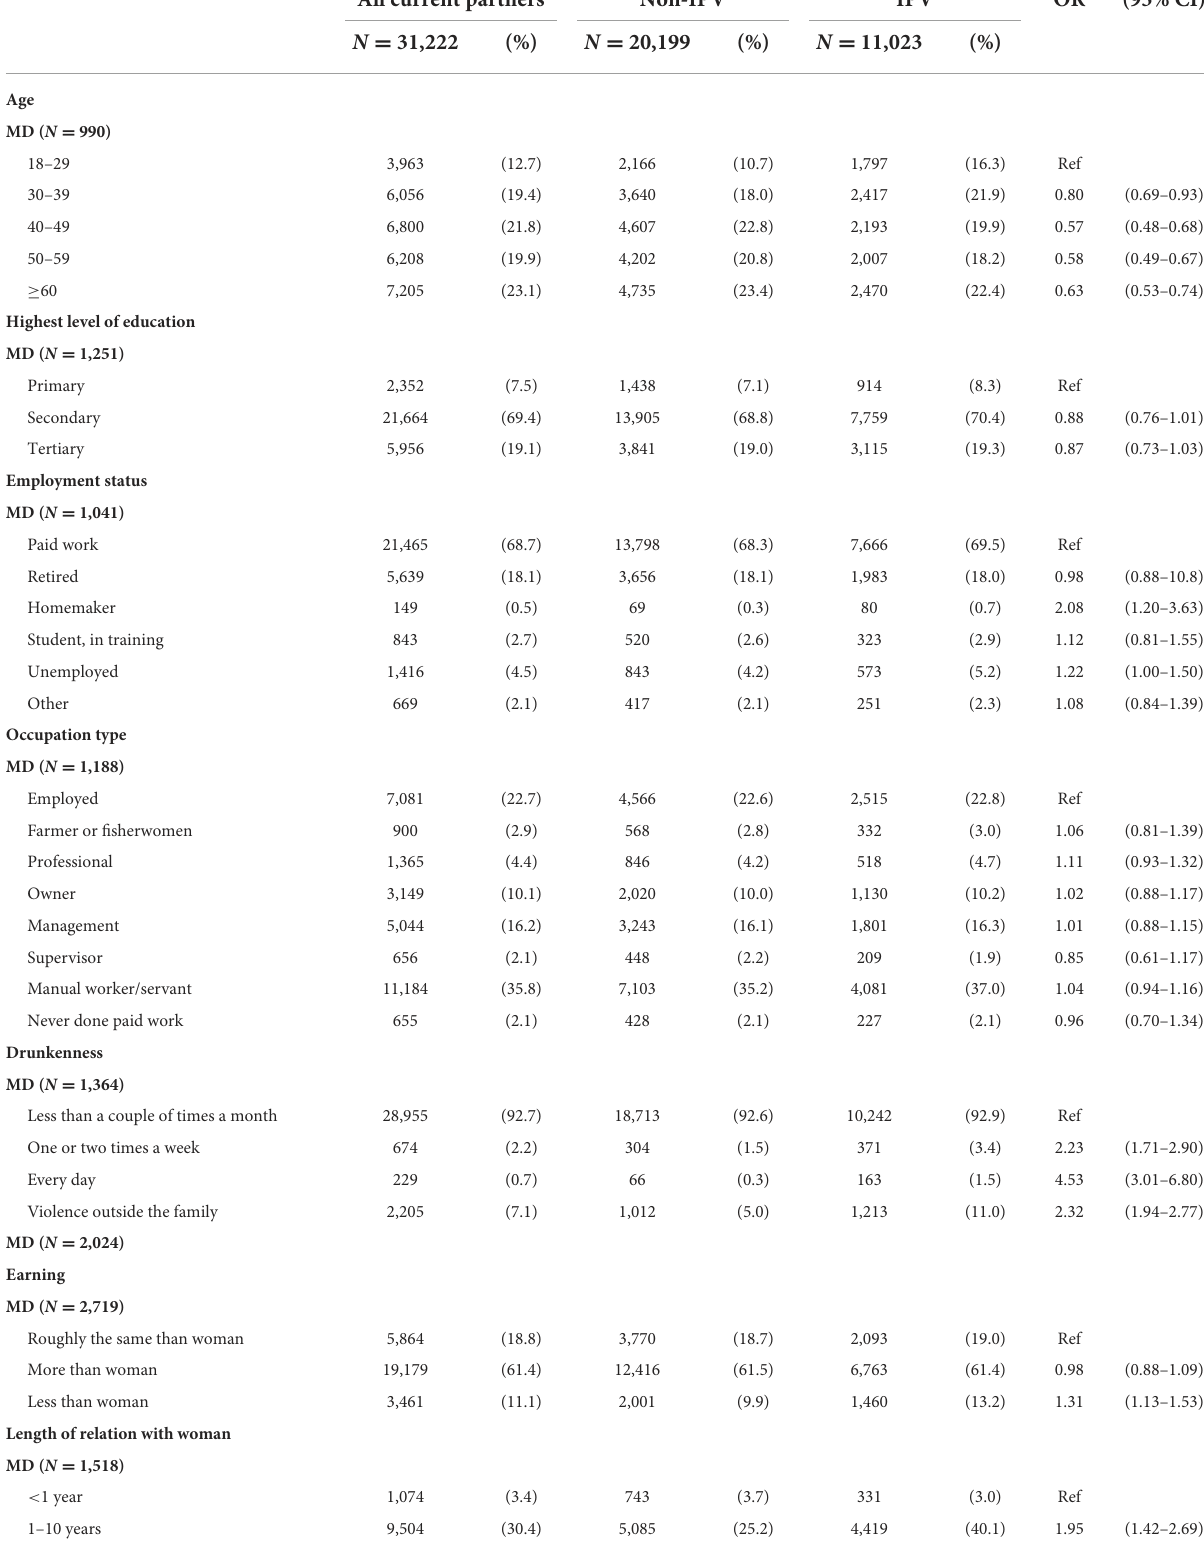
TABLE 2 General characteristics of current partners of the whole population and victims and non-victims of intimate partner